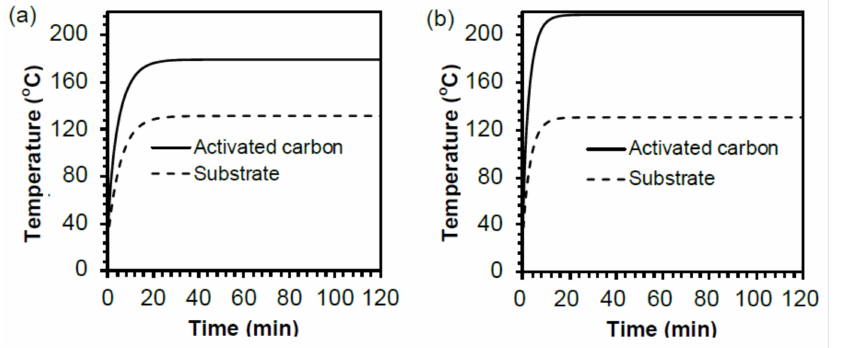
Figure 6. Differences in temperatures between the activated carbon particles and the temperatures in the solution bulk: ( a ) under normal heating with 2.90 W microwaves and ( b ) under heating with 5.60 W microwaves with